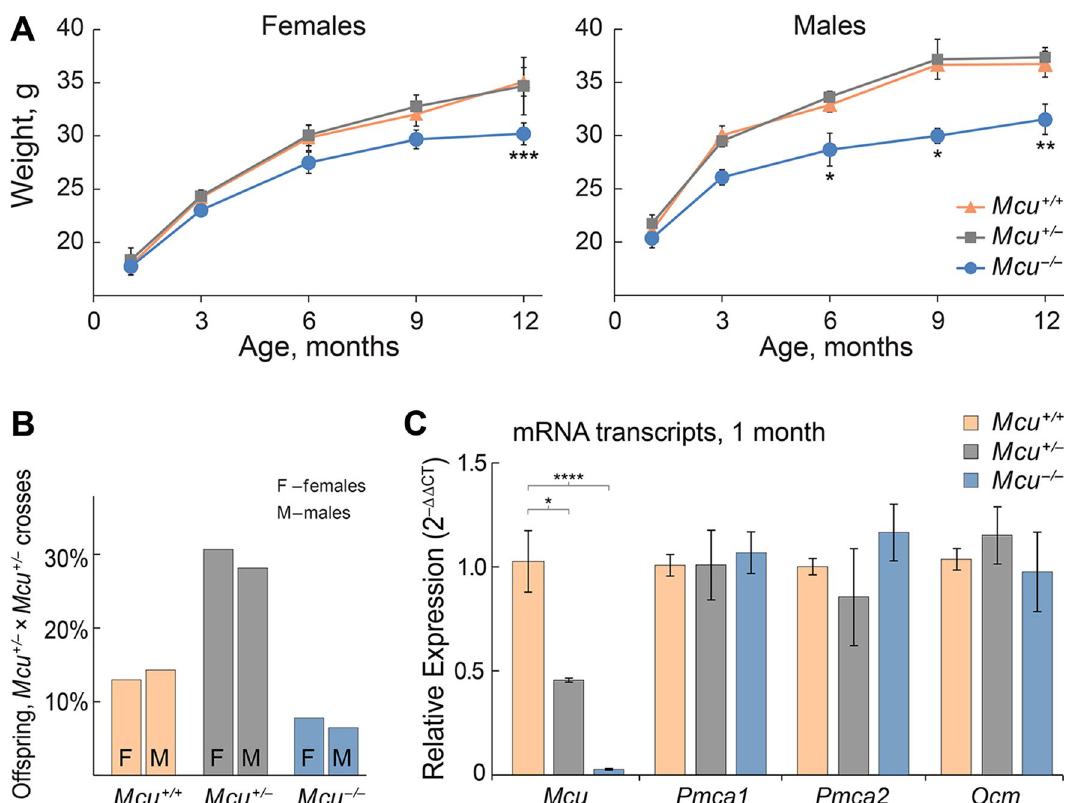
Figure 2. Mcu −/− mice on the FVB/NJ background are smaller in size. ( A ) Mcu −/− mice have smaller body sizes and reduced body weight in comparison to Mcu + /− and Mcu + / + littermates. Number of female mice ( Mcu + / + , Mcu + /− , Mcu −/− ): 1 month (12, 11, 11); 3 months (12, 21, 11); 6 months (7, 15, 9); 9 months (10, 17, 13); 12 months (5, 7, 5). Number of male mice ( Mcu + / + , Mcu + /− , Mcu −/− ): 1 month (12, 15, 6); 3 months (15, 17, 6); 6 months (8, 22, 9); 9 months (5, 12, 7); 12 months (3, 16, 3). ( B ) Percentage of female (n = 39) and male (n = 37) offspring obtained from Mcu + /− × Mcu + /− crosses (8 litters). ( C ) Relative quantitation of the mRNA levels of Mcu , Pmca1 , Pmca2 , and Ocm in the cochlea of FVB/NJ mice of Mcu −/− and Mcu + /− genotypes as compared to those of Mcu + / + littermates. Cochleae obtained from 6 animals each of Mcu + / + , Mcu + /− , Mcu −/− genotypes at 1 month of age were used for studying gene expression. * p < 0.05, ** p < 0.01, *** p < 0.001, **** p < 0.0001, Two way ANOVA followed by Bonferroni multiple comparison